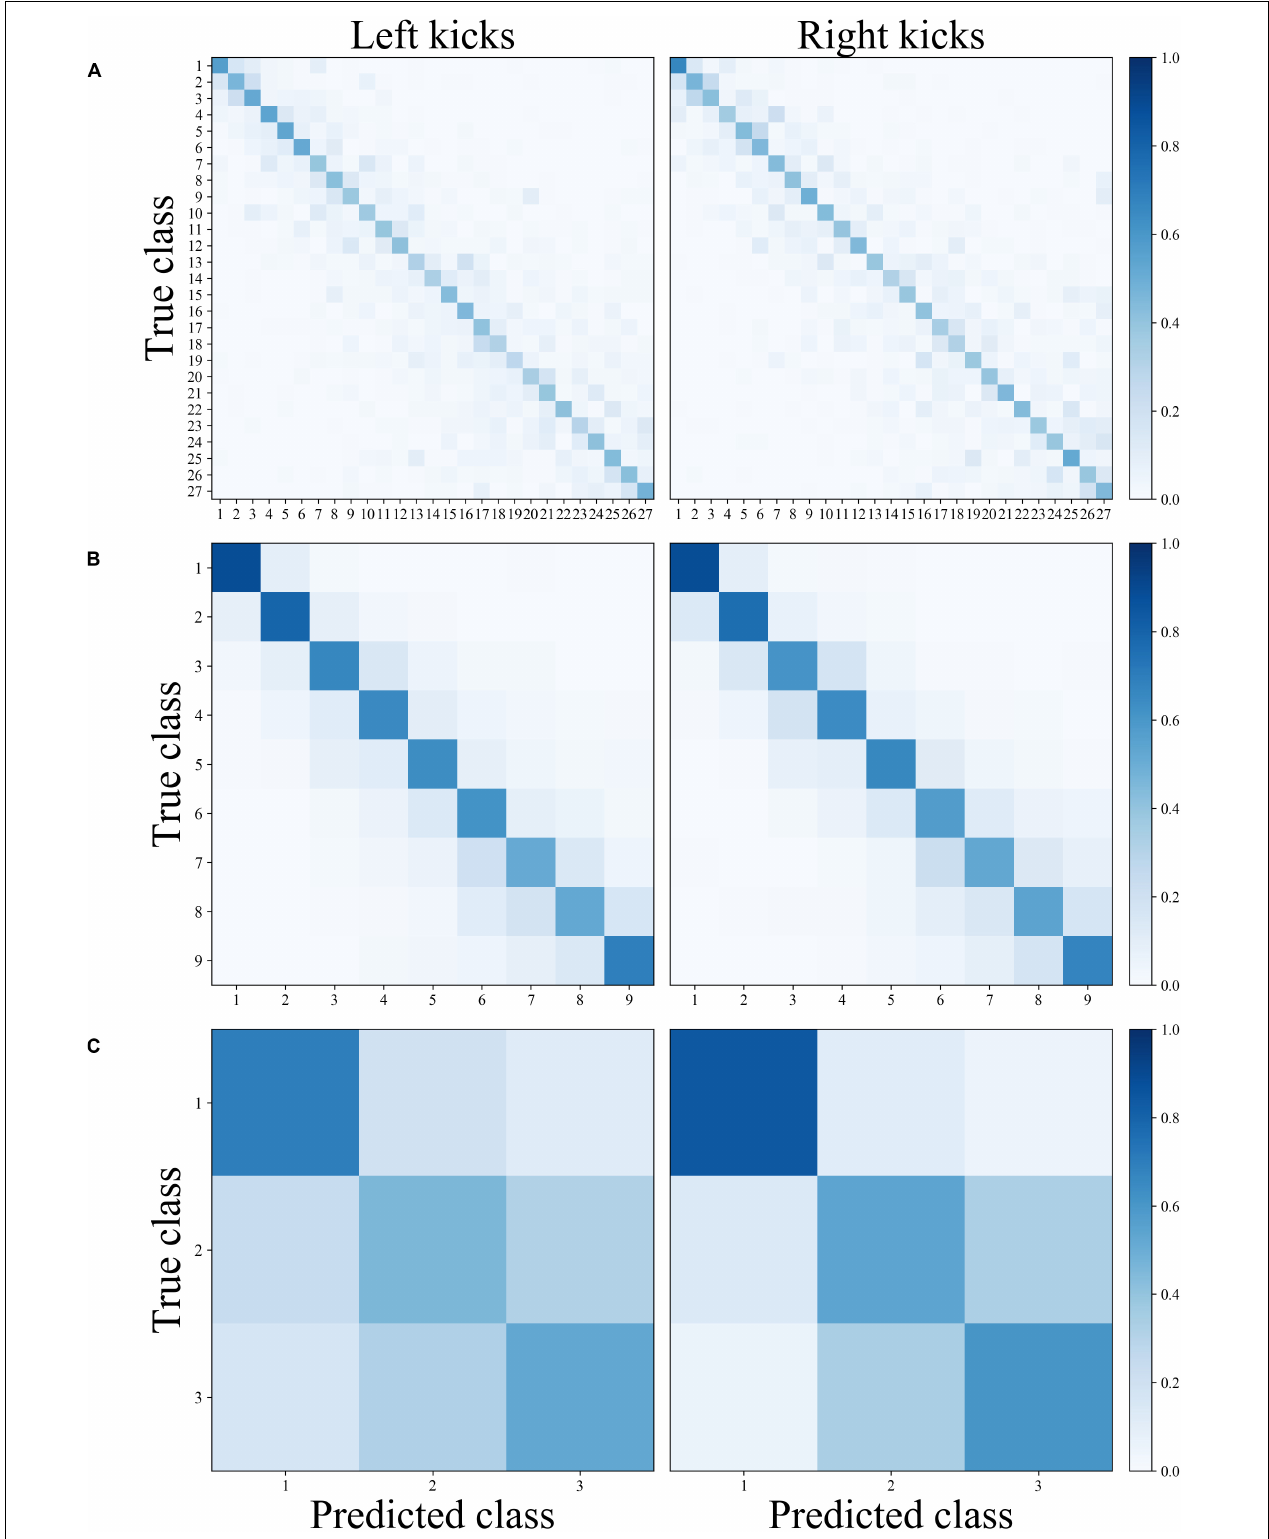
FIGURE 3 | Normalized confusion matrices of the classification’s movement patterns of the left and right kicks depending on the different classification tasks. (A) Block classification, (B) set classification, and (C) block-within-set classification.